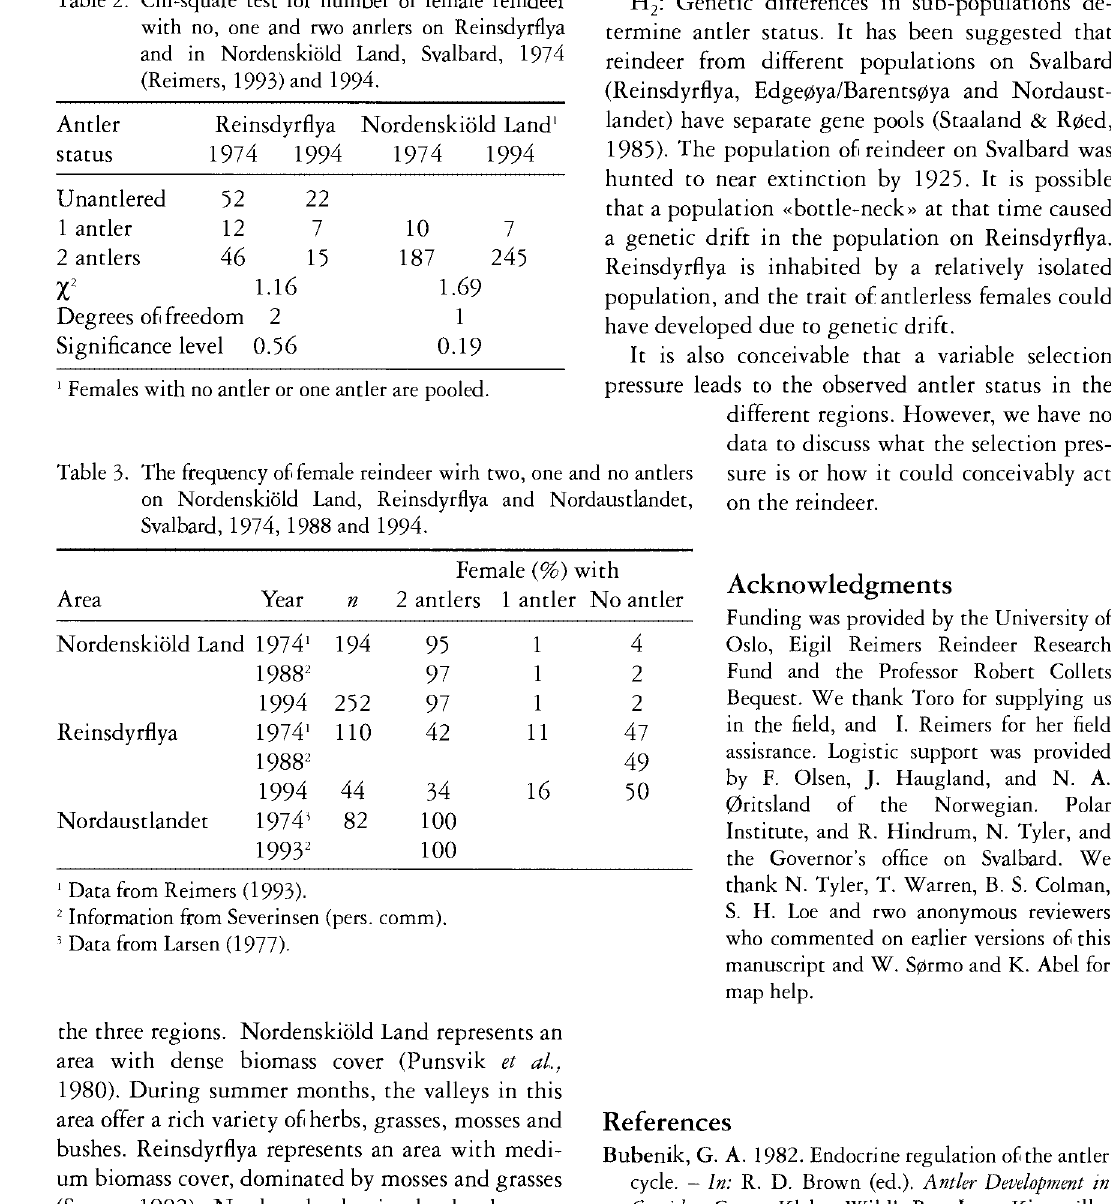
Table 2. Chi-square test for number of female reindeer with no, one and rwo anrlers on Reinsdyrflya and in Nordenskiold Land, Svalbard, 1974